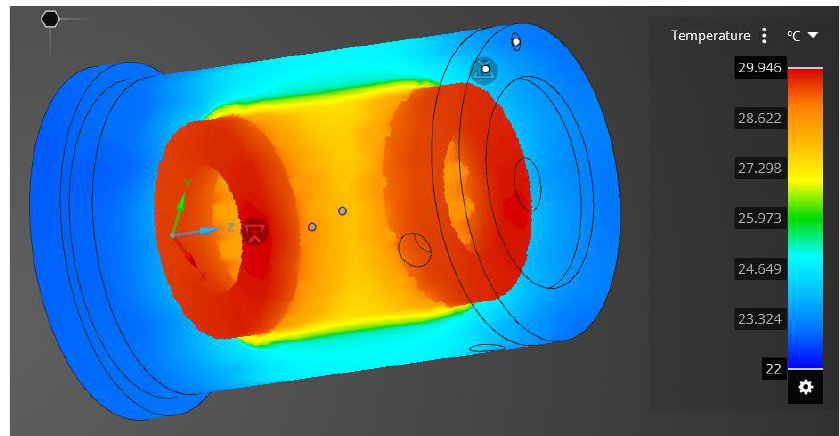
Figure 14. The FEM thermal simulation of the liquid cooling jacket. Energies 2022 , 15 , x FOR PEER REVIEW